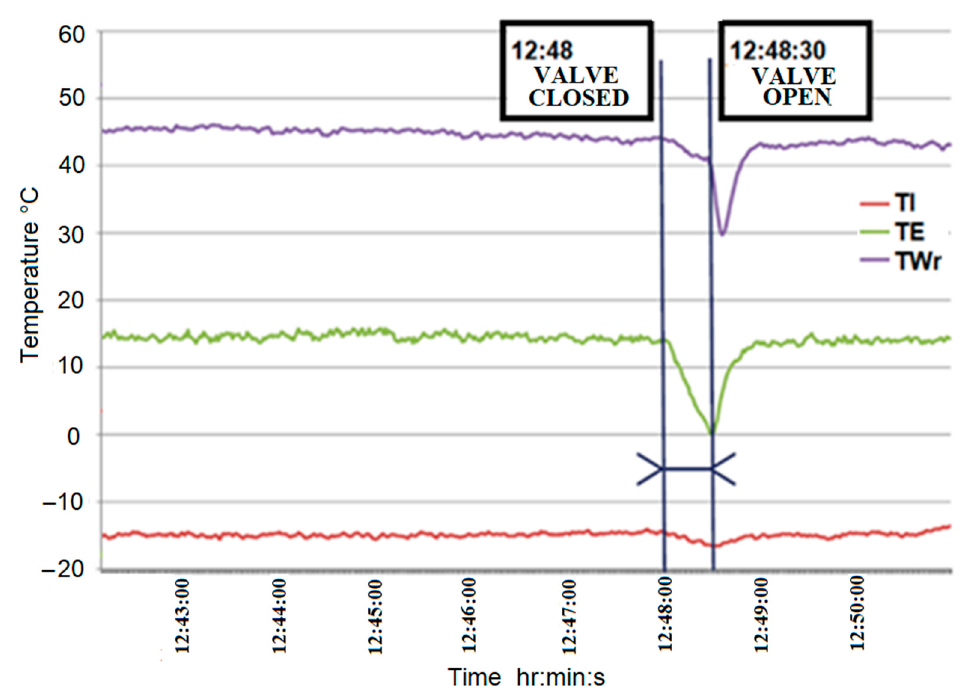
Figure 7. Records of the test used for calibration of the model parameters.